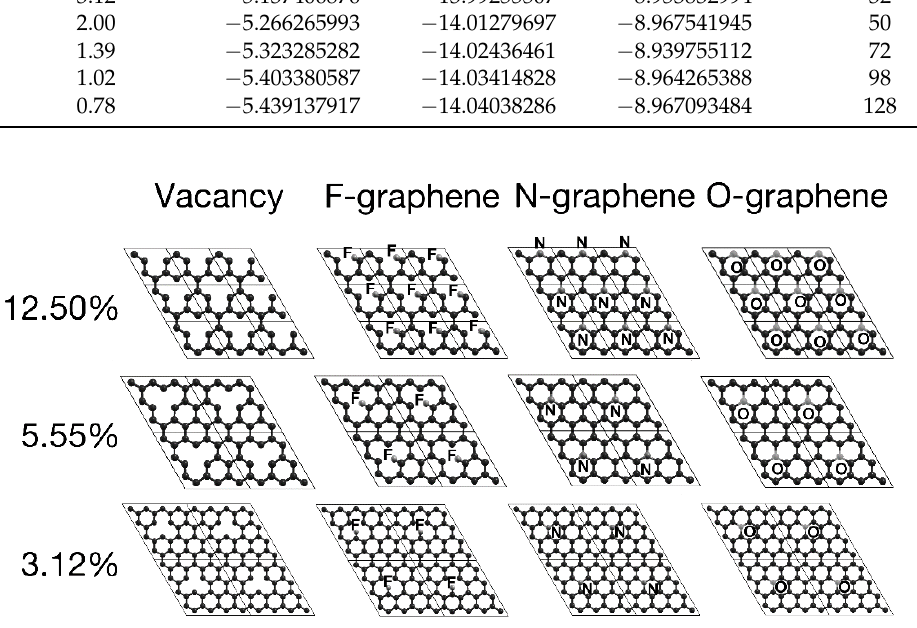
Figure 1. Top view of the XY plane for graphene vacancy/dopant at: 12.5% top, 5.55% middle, and 3.12% bottom. We mark the boundaries of the unit cells with lines.